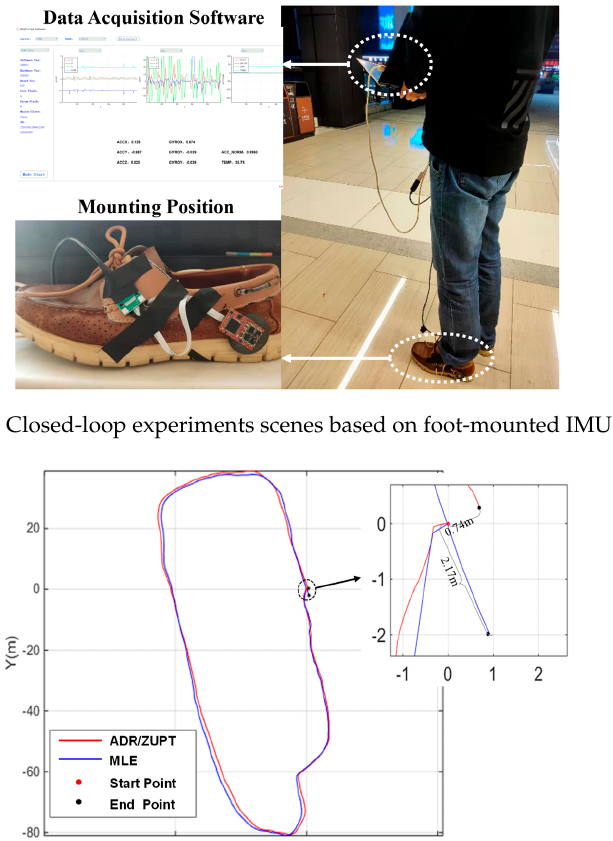
Figure 13. Positioning results of eight IMUs on the array in one closed-loop experiment. Considering the difference between drift errors of IMU in different tests after powering on, 20 times of repeated powering on tests were carried out in the closed-loop track, including 10 times tests in line with the direction shown in Figures 6 and 10 times in the opposite direction. In 20 statistical